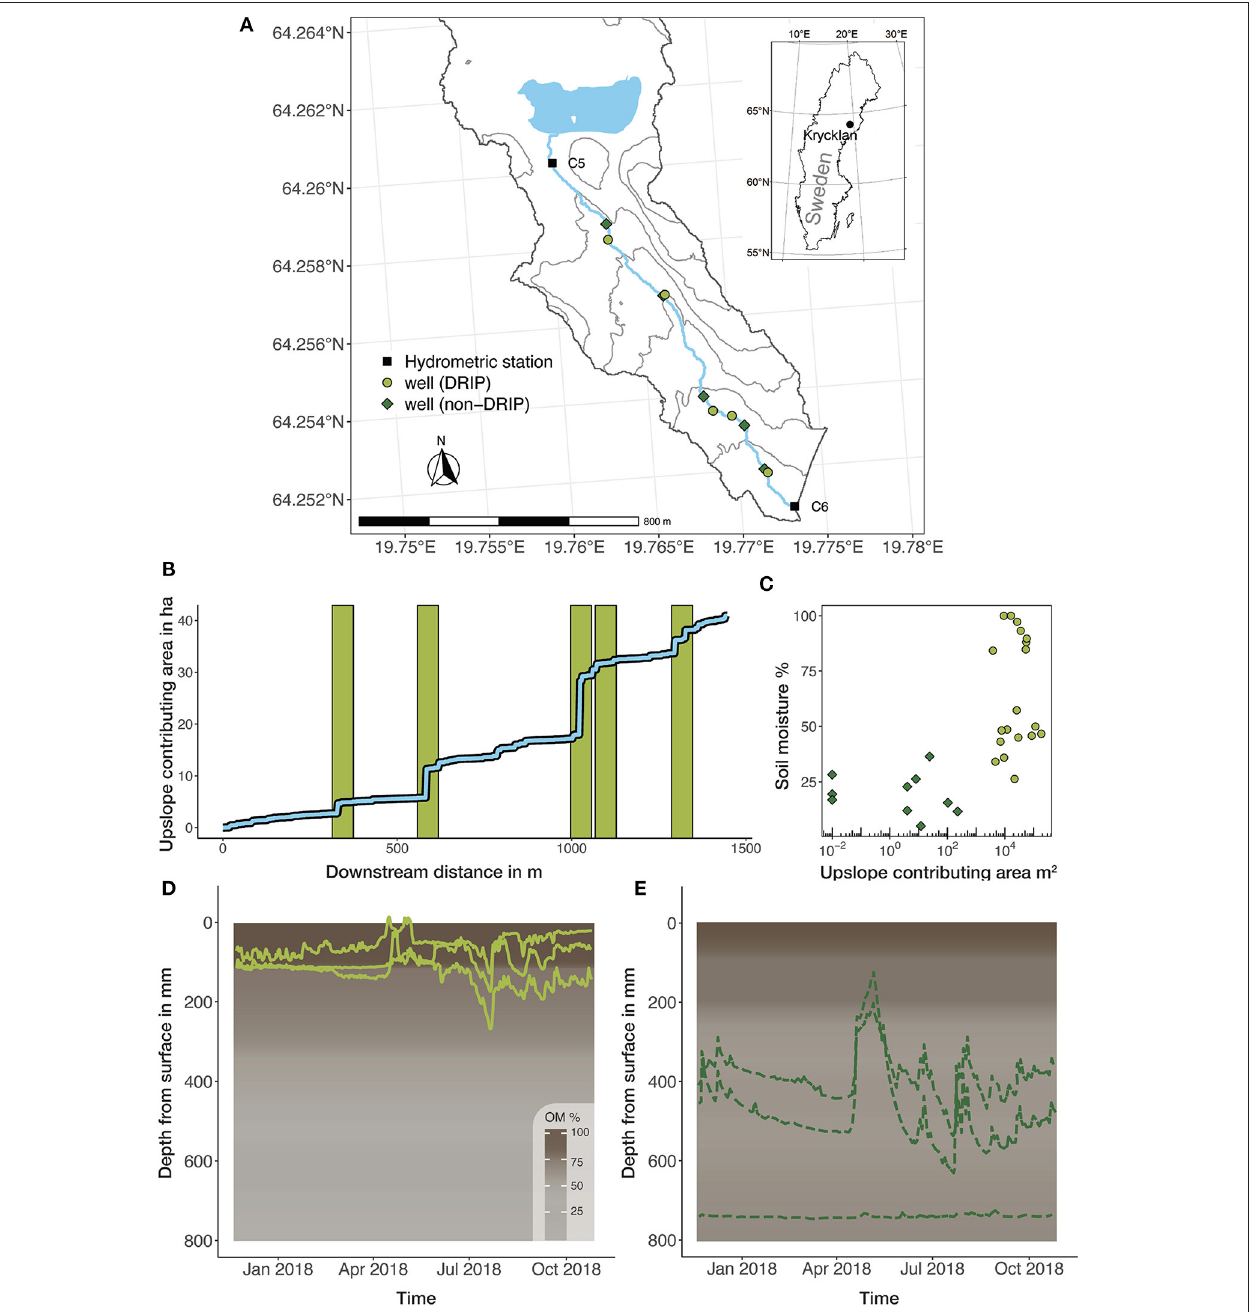
FIGURE 1 | DRIPs along the C5-C6 headwater reach. (A) shows an inset map of Krycklan in Sweden and the C6 catchment. Hydrometric stations C5 and C6 are indicated by black squares, and DRIP and non-DRIP wells are indicated in light green circles and dark green spades, respectively. (B) shows in light blue the gain in upslope contributing area along the stream reach, from C5 to C6. The light green vertical bars show the approximate location of the DRIPs along the reach. (C) shows a summer snapshot of soil moisture percentage of DRIPs and non-DRIPs across the Krycklan catchment relative to their upslope contributing area. (D) shows daily time-series of depth to groundwater from three DRIP wells during the hydrological year 2018. The background shows a color gradient from dark brown to gray that represents the 10cm aggregated mean organic matter percentage (OM%) from DRIPs ( n = 12). (E) shows in a similar fashion the depth to groundwater from three non-DRIP wells, and the OM% of non-DRIPs ( n = 12). levels close to the surface ( Figure 1D ), while the surrounding surface in response to rain or snowmelt inputs ( Figure 1E